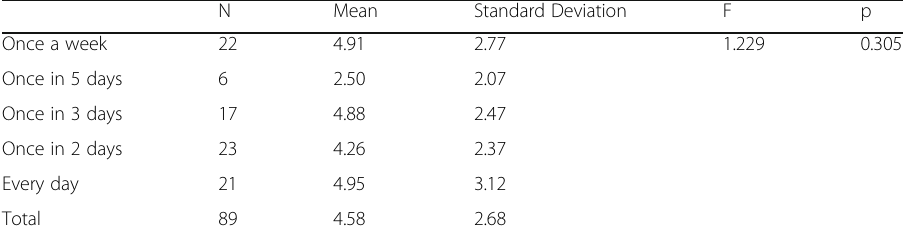
Table 6 ANOVA results for effect of frequency of studying using internet to mental effort N Mean Standard Deviation F p Once a